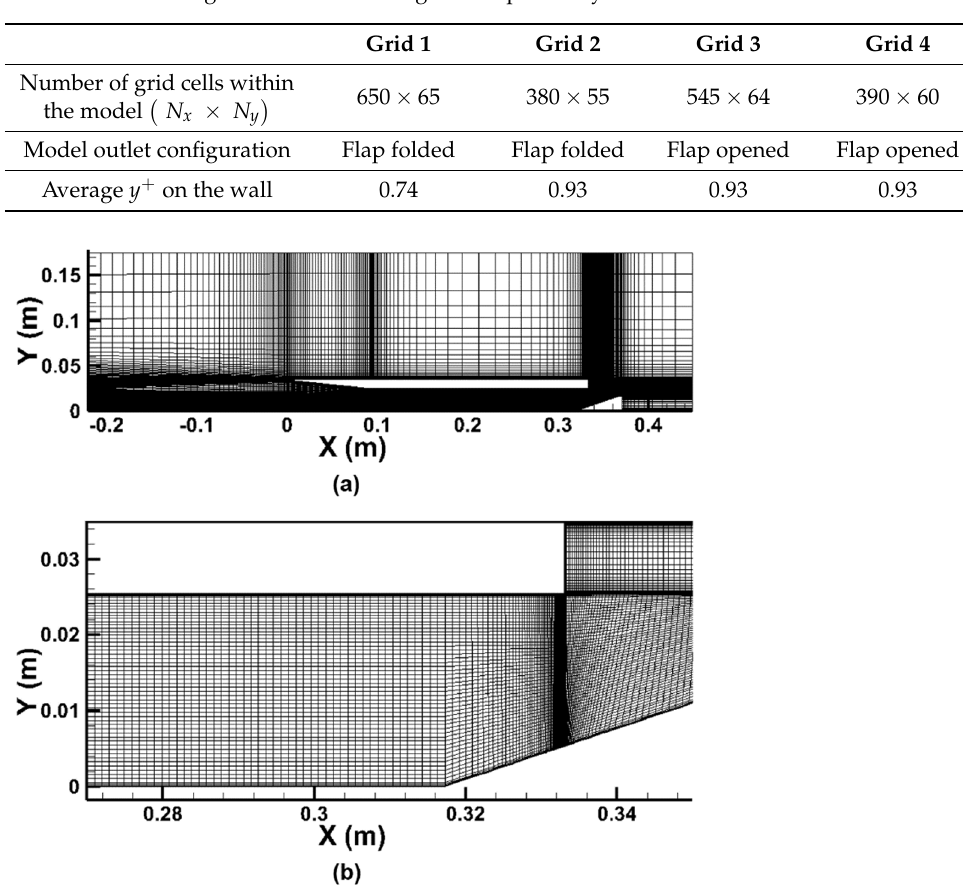
Figure 2. Computational grid for the inlet-isolator model: ( a ) grid for the entire domain; ( b ) enlarged picture of the grid near the model outlet.